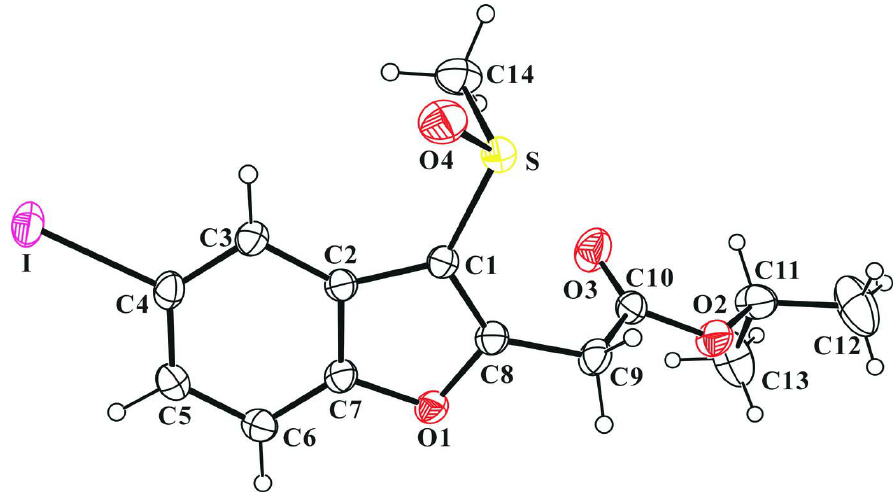
Figure 1 The molecular structure of the title compound, showing displacement ellipsoids drawn at the 30% probability level.